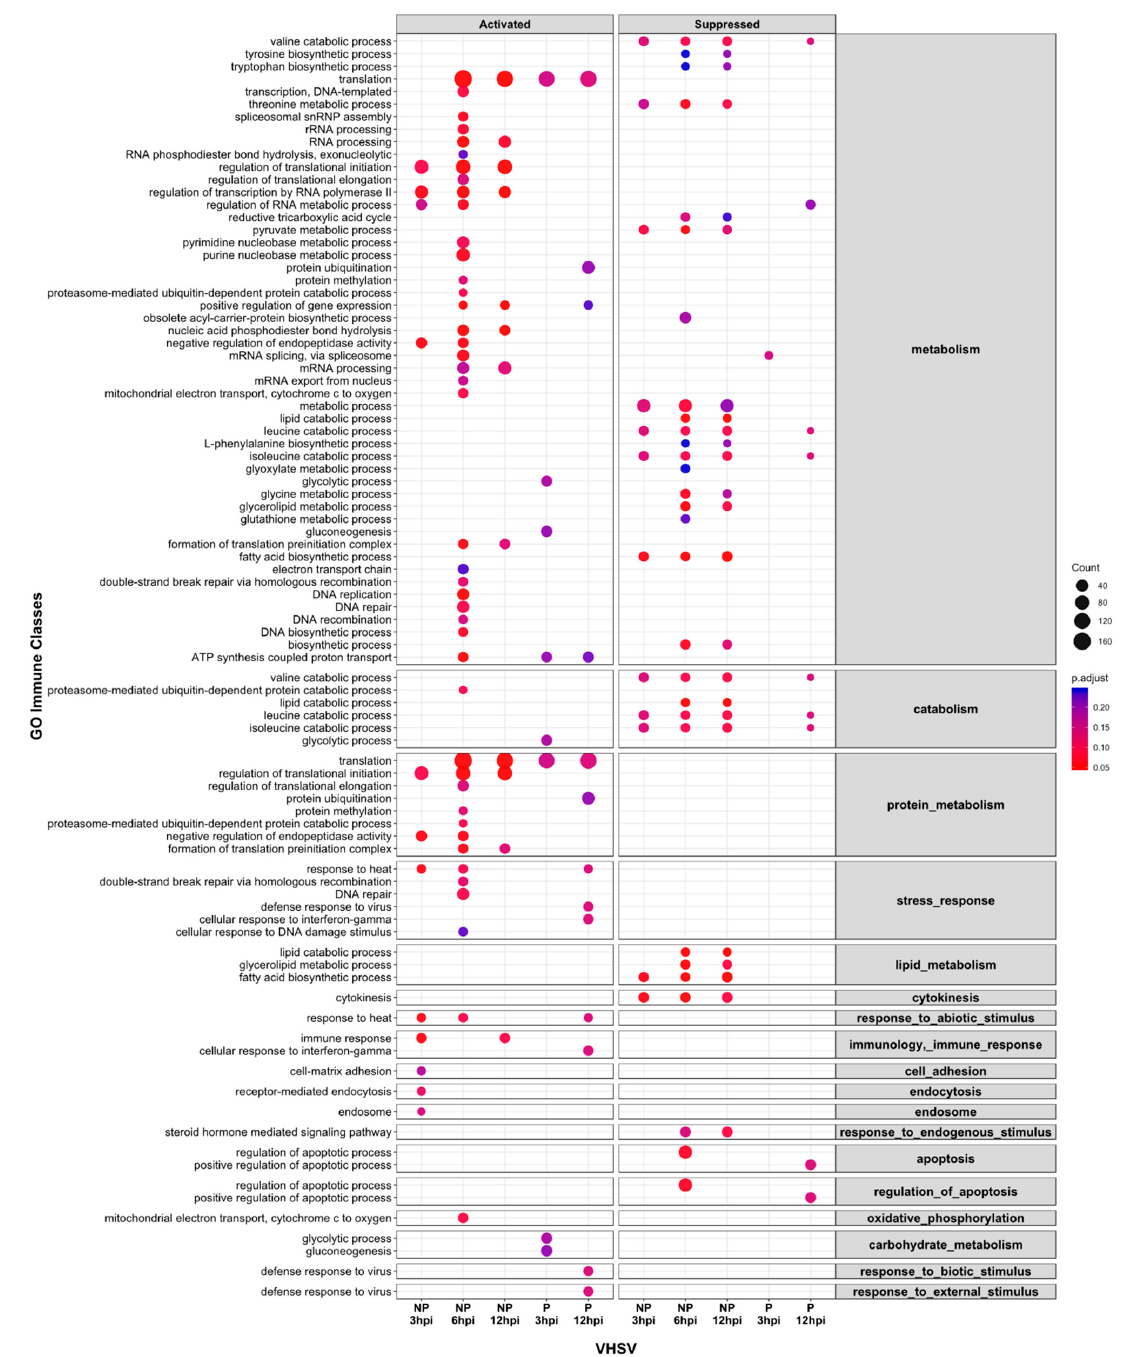
Figure 3. Dot plot of grouped enriched gene ontology (GO) terms into immune classes for the non-pathogenic (NP) 1p49 and pathogenic (P) J167 viral haemorrhagic septicaemia virus (VHSV) isolates at 3, 6, and 12 h post-inoculation (hpi), based on gene set enrichment analysis of all transcripts. The size and colour of each dot represent the number of genes and adjusted p values (Benjamini–Hochberg correction; FDR < 0.25), respectively.